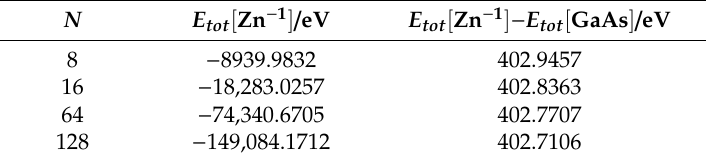
Table 1. The total energy of an N atoms large GaAs supercell containing one Zn atom on a Ga site and the di ff erence in total energy of two N atoms large GaAs supercells, one containing one Zn atom on a Ga site and the other one defect free